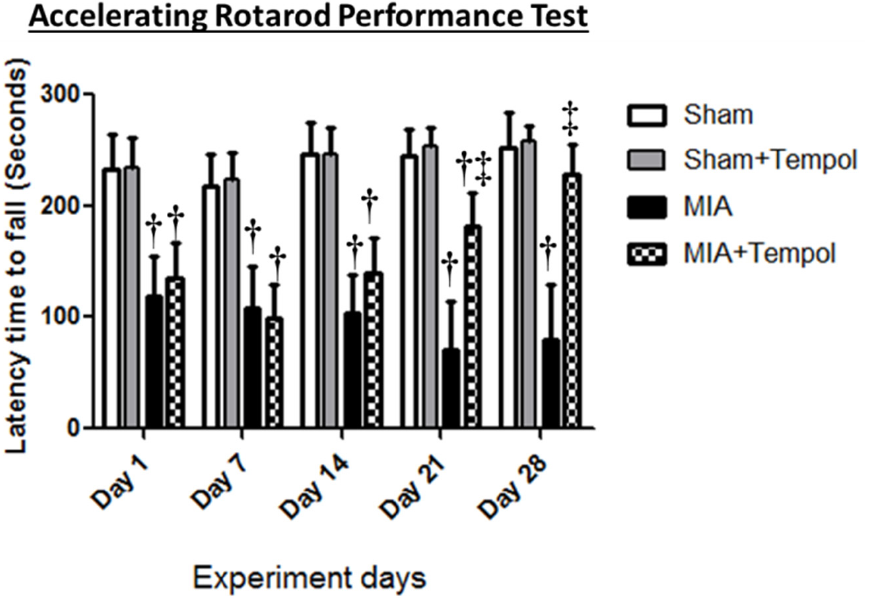
Figure 2. Effect of Tempol on the Rotarod test. Rats were subjected to a single intra-articular injection of 3 mg MIA/50 µ L saline in their right knees, and then tempol was administered starting from the 7th day of the experiment in a dose of (100 mg/kg/day) by oral gavage for 21 consecutive days. Values of latency time to fall are expressed as mean ± SD ( n = 8). Statistical analysis was carried out using repeated measures ANOVA test for factors time and group, followed by the Bonferroni test. † p < 0.05 vs. the sham group, and ‡ p < 0.05 vs. MIA group.